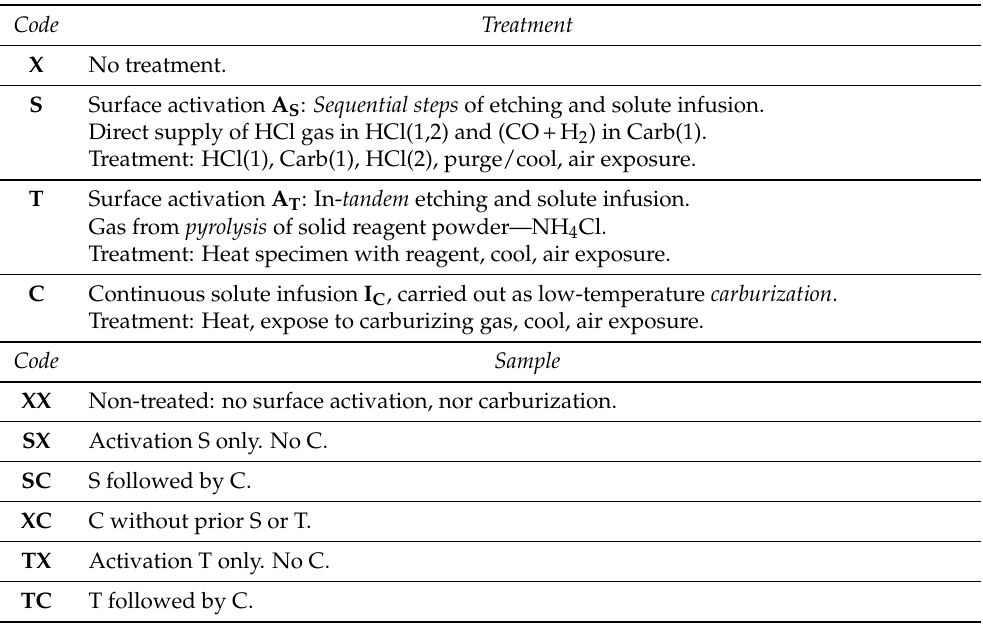
Table 1. Treatment- and sample